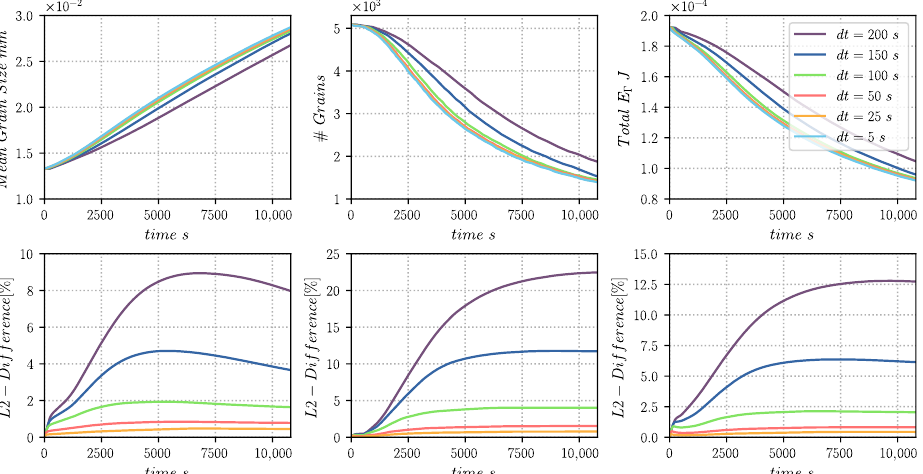
Figure A2. Sensitivity to the time step dt for the 2D heterogeneous GG test case using the TRM model and h trm = 0.003 mm. The evolution of different parameters is given when using the RS function for the determination of the GB energy γ as a function of the disorientation angle θ : ( left ) grain size, ( center ) number of grains, and ( right ) total GB energy. Each value ( top ) is compared to the evolution of the smallest dt . L2-difference values are given ( bottom